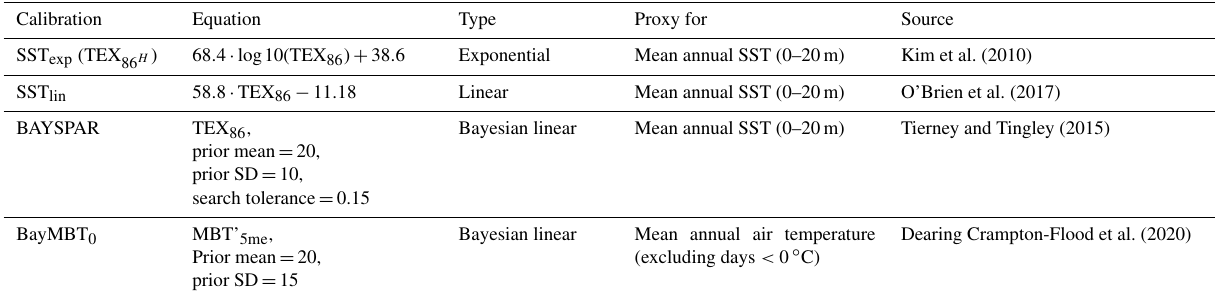
Figure 3. Variations in fractional abundances of the various branched (green) and isoprenoid (blue) GDGTs, and branched GMGTs (red) at ODP Site 1172. Table 2. Calibration equations for TEX 86 and